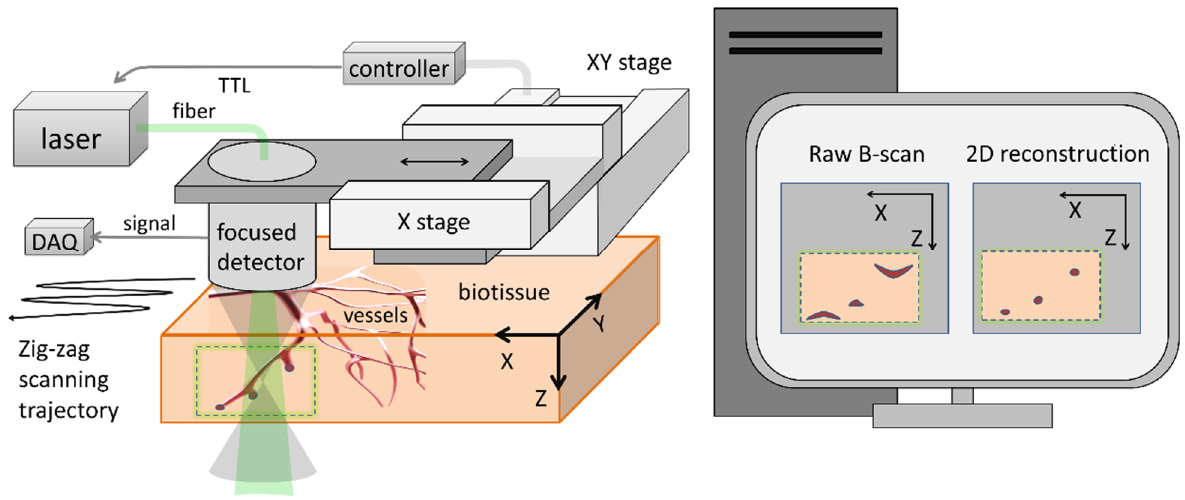
Figure 1. Raster-scan OAM angiography with simultaneous acquisition and SAFT reconstruction.